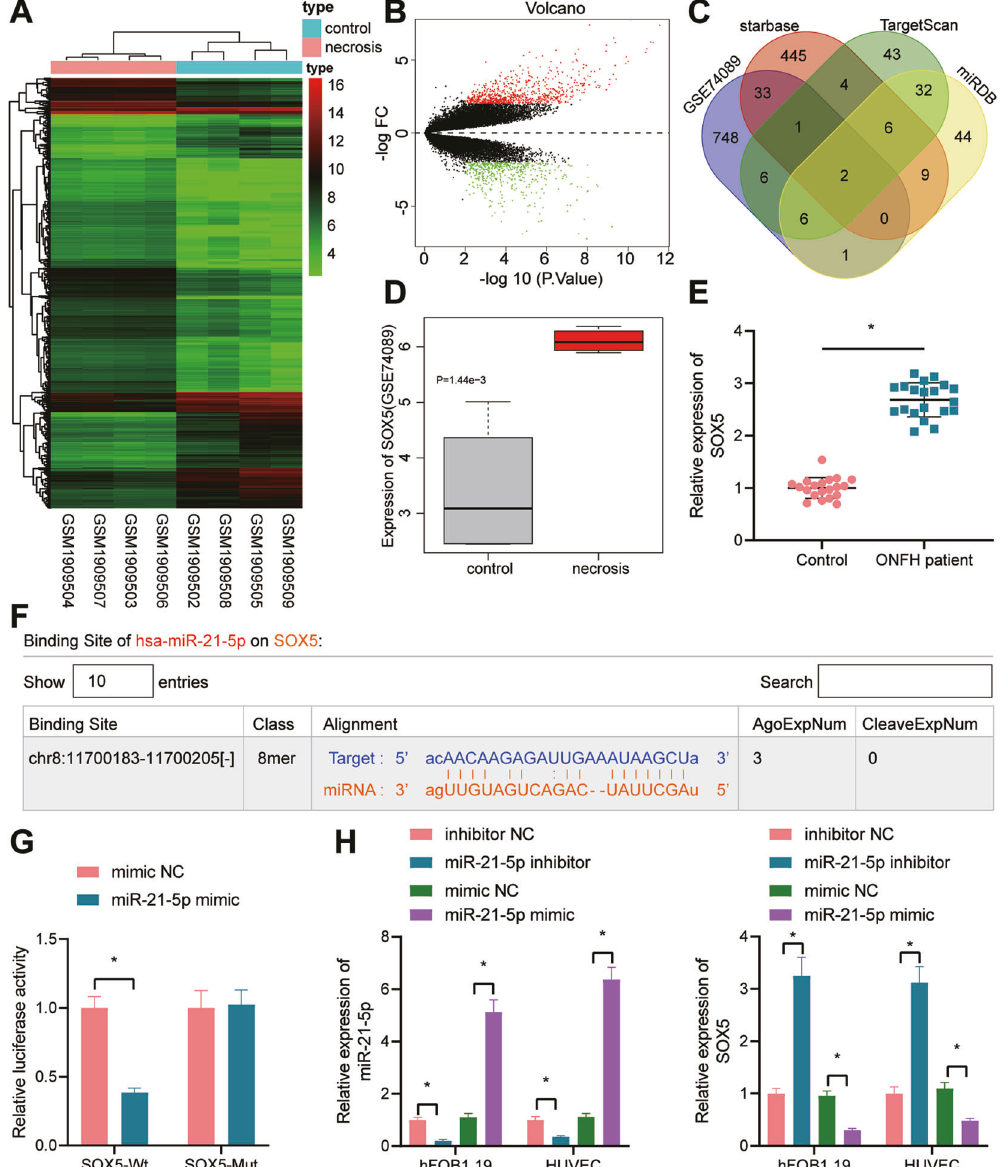
map of signi fi cantly differentially expressed genes in ONFH samples of GSE74089 dataset. Red represents upregulated genes, while green represents down-regulated genes, |logFC | > 2, p < 0.01; C the Venn diagram of intersection among signi fi cantly upregulated genes from the GSE74089 dataset, the top 500 target genes by miR-21-5p predicted by the starBase database and the top 100 target genes predicted by the TargetScan and miRDB databases; D SOX5 expression predicted in the GSE74089 dataset. Red box indicates ONFH samples, while gray box indicates normal samples; E SOX5 mRNA expression in the cartilage tissues of patients with ONFH ( n = 20) and patients with femoral neck fracture (normal control, n = 20) determined with RT-qPCR; F the binding site of miR-21-5p and SOX5 predicted with TargetScan; G the targeting relationship between miR-21-5p and SOX5 veri fi ed with dual-luciferase reporter gene assay; H the expression of miR-21-5p and SOX5 in hFOB1.19 cells and HUVECs determined with RT-qPCR. Cell experiment was repeated three times independently. * p <